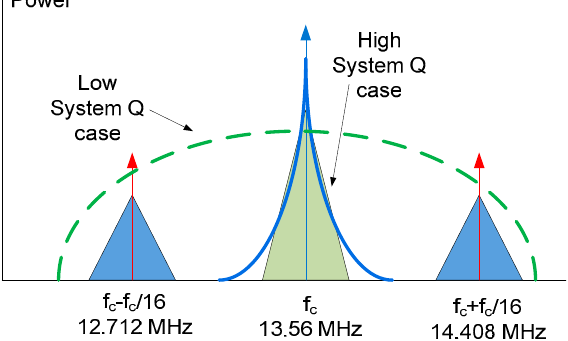
Figure 2. A typical spectrum of an NFC radio-frequency identification (RFID) system illustrating the reader command around the carrier frequency and the load modulation at the sidebands. The impact of increasing the reader Q factor is also shown.